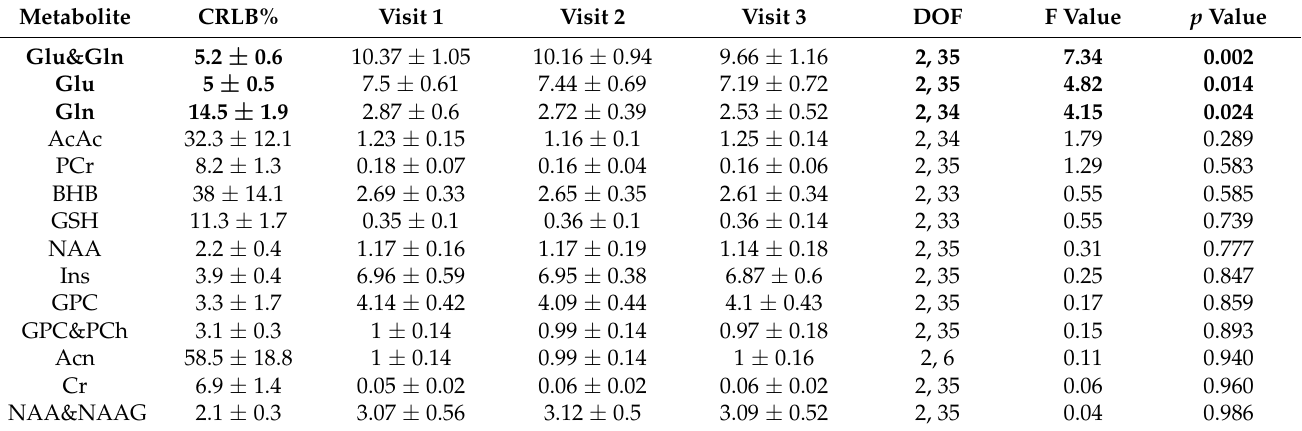
Table 4. MRS metabolite reliability measures, descriptive statistics, and omnibus statistical results over the baseline (V1), after one dose (V2), and after multiple (V3) empagliflozin